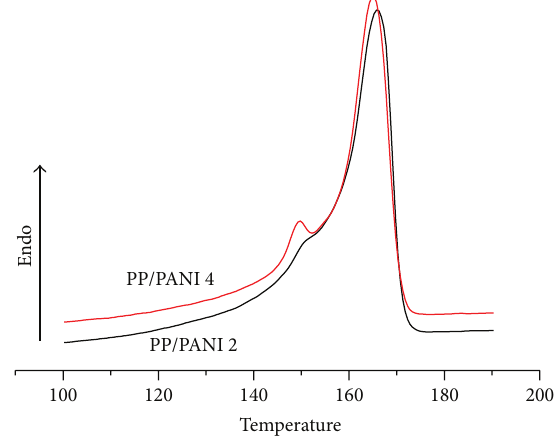
Figure 1: DSC heating thermograms of PP/CPP/PANI blends.